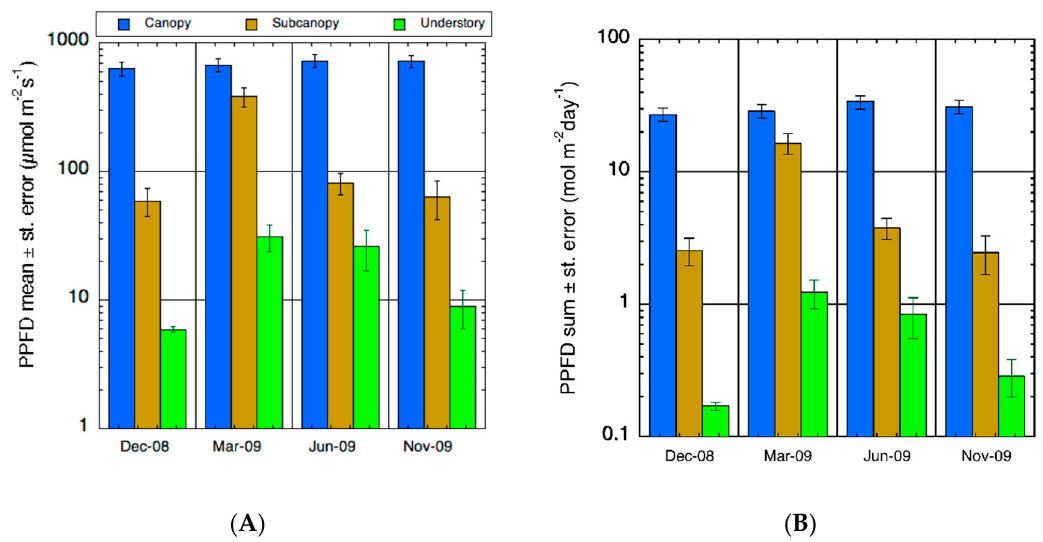
Figure 1. Environmental variables at Castilla novel forest. ( A ) Mean photosynthetic photon flux density (PPFD mean ) and ( B ) total photosynthetic photon flux density (PPFD sum ) per day for the different forest strata during four measuring periods ( n = 60–62).